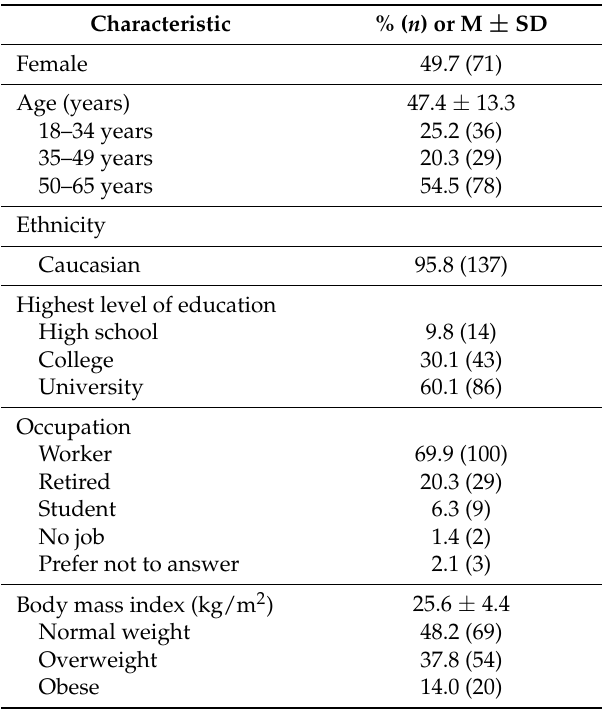
Table 1. Sample characteristics of the validation study ( n =